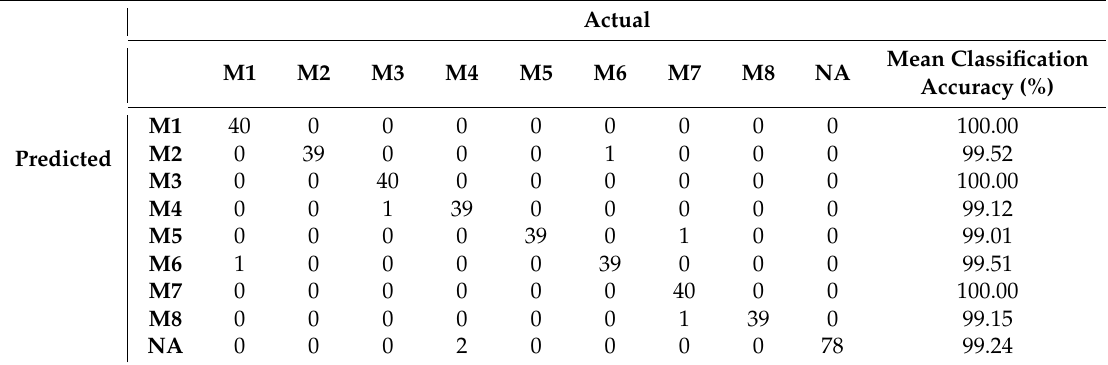
Table 8. Confusion Matrix of PNN of proposed PEN3-PCA hybrid feature for 50 repetition.